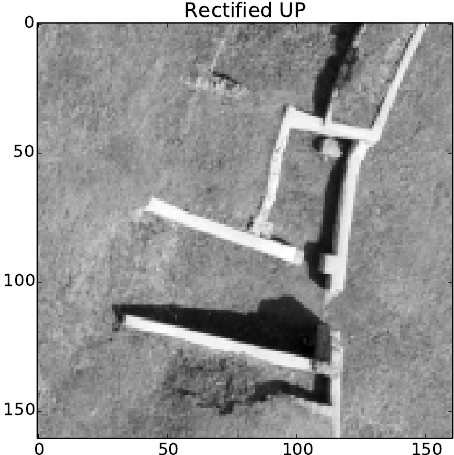
Figure 4: Detail of grey-scale version of fig. 2, rotated and scaled to match the imaged area of fig. 5, with cast shadows.